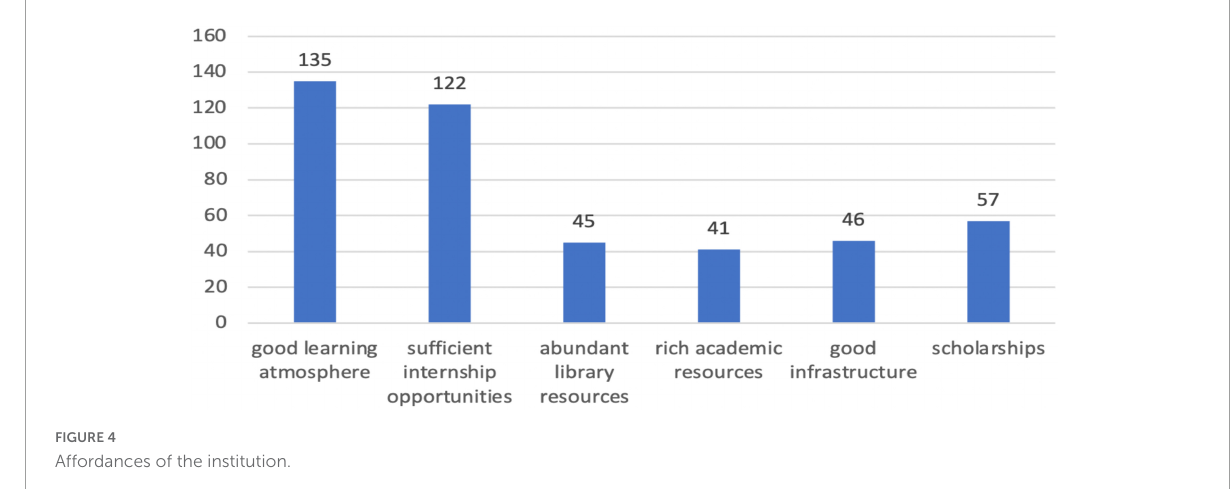
FIGURE4 Affordances of the institution.